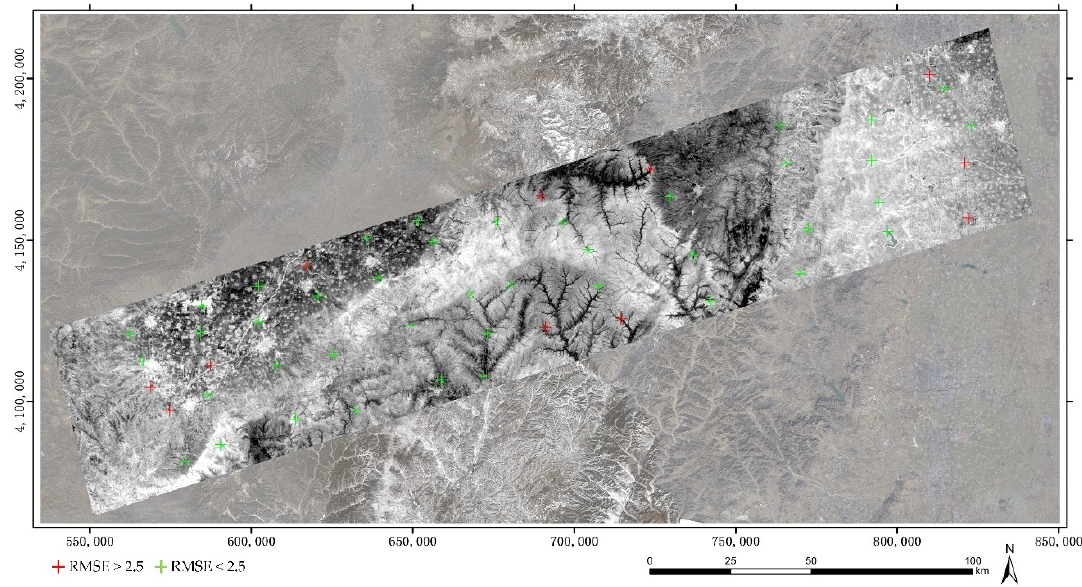
Figure 13. The GCPs which are distributed uniformly in the image are selected manually (UTM, 49 N). 49